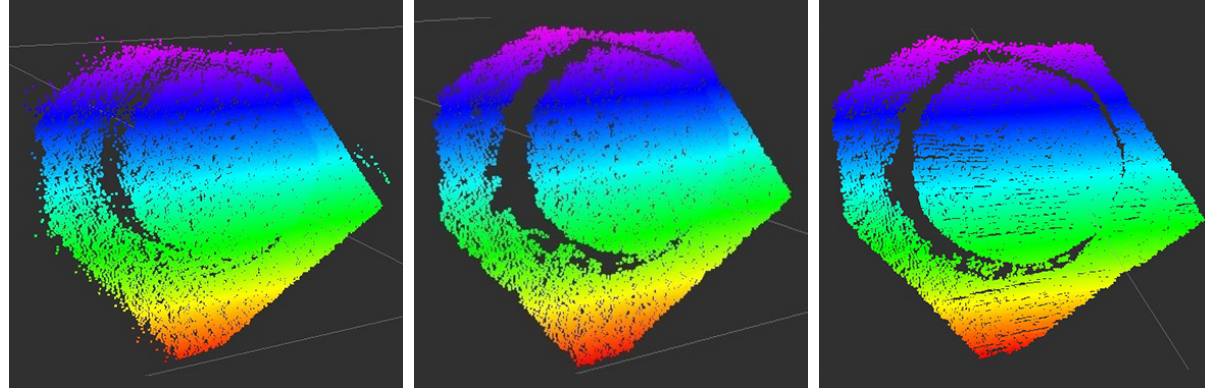
Figure 7. Plane without filtering ( left ) and with applied Statistical Outlier Removal Filter ( middle ). It can be seen that outliers at the edges are removed. When applying the Median filter, further smoothing of the point cloud occurs ( right